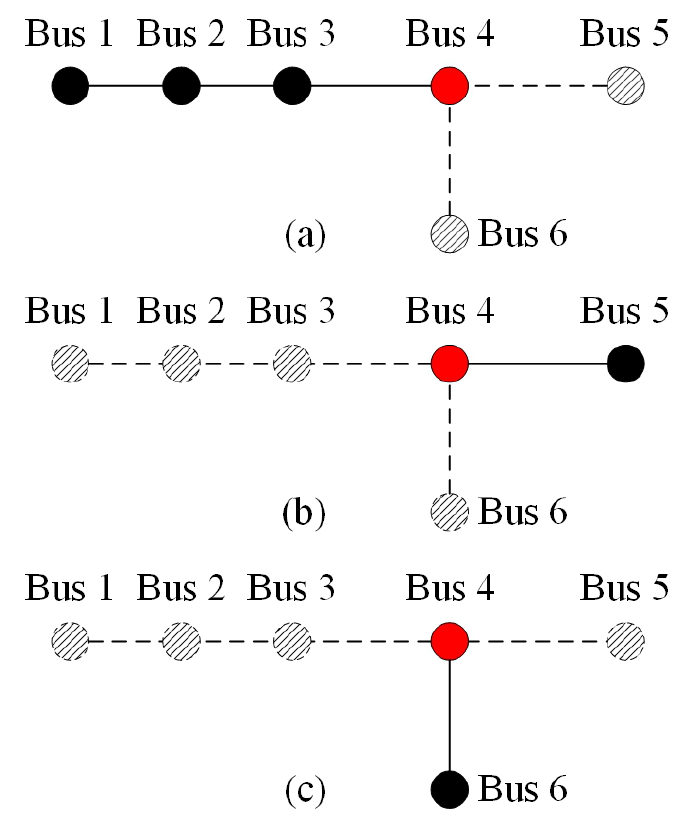
Figure 3. Vertex-cut partitioning example with PMU located at Bus 4. ( a ) partition 1 with buses 1, 2, 3, and 4; ( b ) partition 2 with buses 4 and 5; ( c ) partition 3 with with buses 4 and 6.